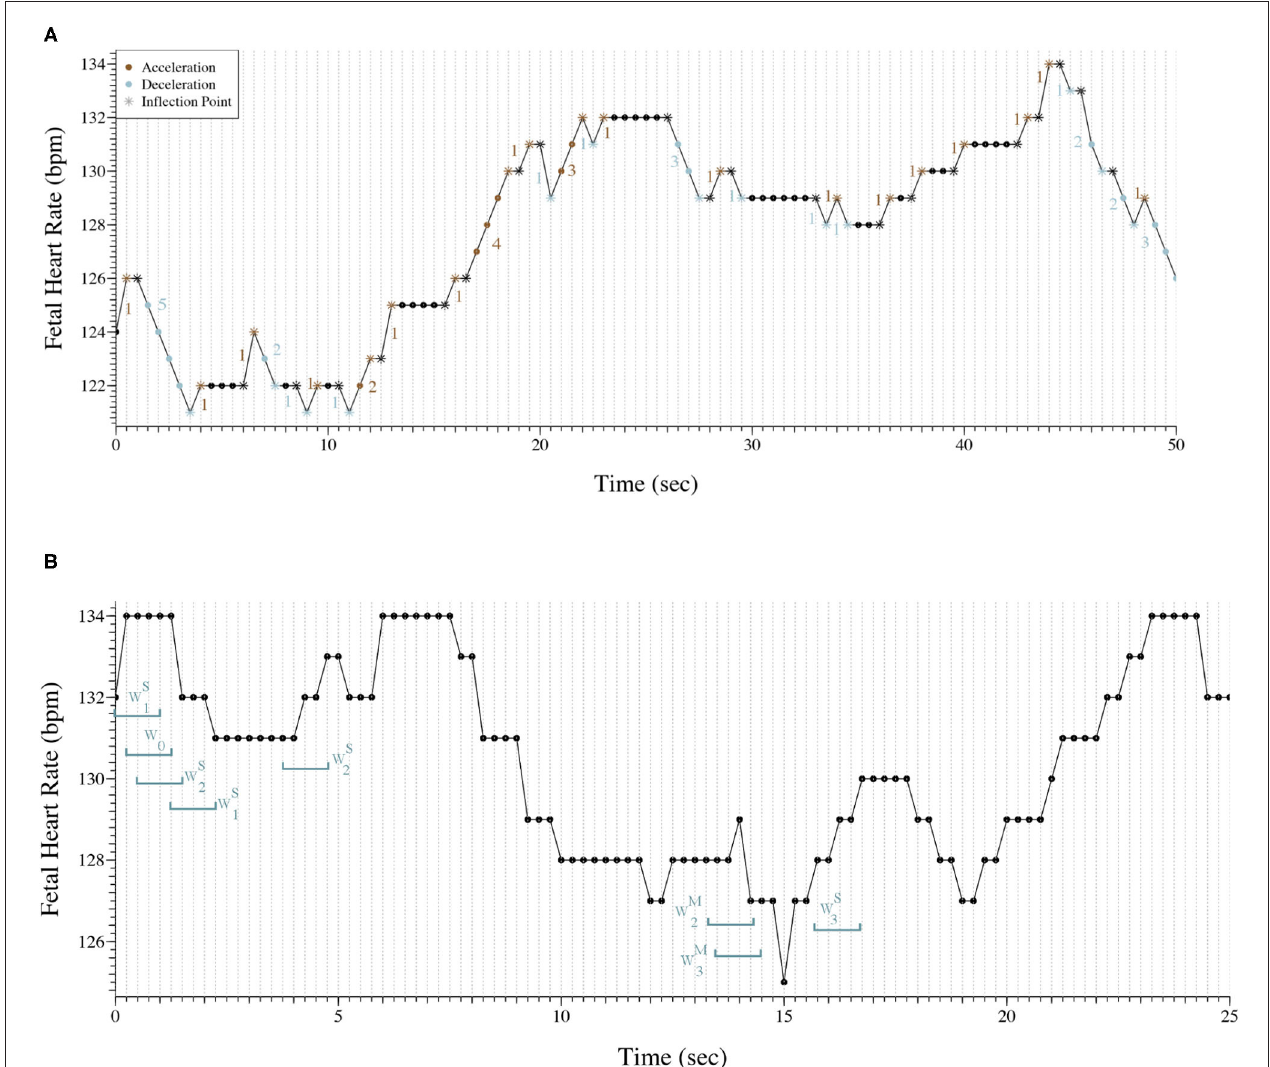
FIGURE 1 | (A) Representation of 50 s of a fetal heart rate time series sampled at 2 Hz. The trace presents 53 inflection points (*) and there are 33 segments between inflections points that are accelerations or decelerations. PIP =